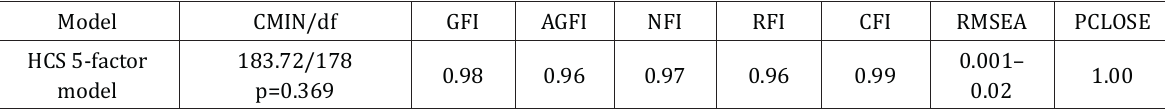
Table 4. Coefficients of confirmatory factor